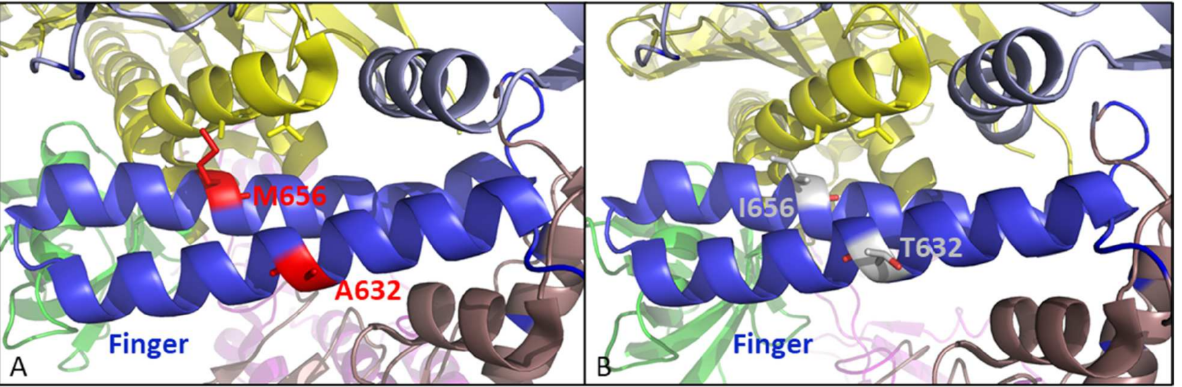
Figure 11. Structure of the interface finger (in blue)/NH2-terminal (in light blue) domains. ( A , B ) A677 (in red) is facing residues E106, K503, and L506 (in grey) at the interface between finger (in blue) and NH2-terminal (in light blue) domains. ( C ) Change at position 670 has been associated with aphidicolin resistance. ( D , E ) Residue L510 was found altered in our study through change L510S selected under the pressure with HPMPC, ( F ) while at position 511, a phenylalanine residue was present in the clones selected under pressure with HPMPO-DAPY. The images were generated using PyMol Delano Software, version 0.99rc6.